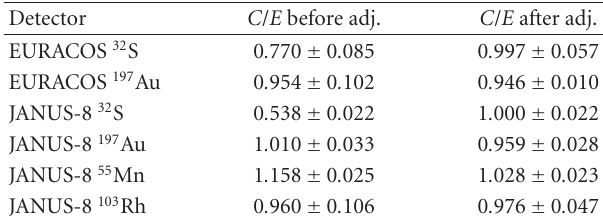
Table 6: C / E before and after statistical adjustment. Detector C / E before